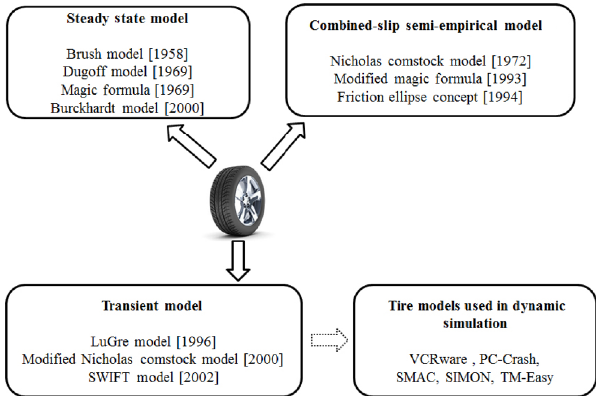
Fig. 12 Different tire models. Reproduce with permission from Ref. [68]. Copyright Singh, 2012.